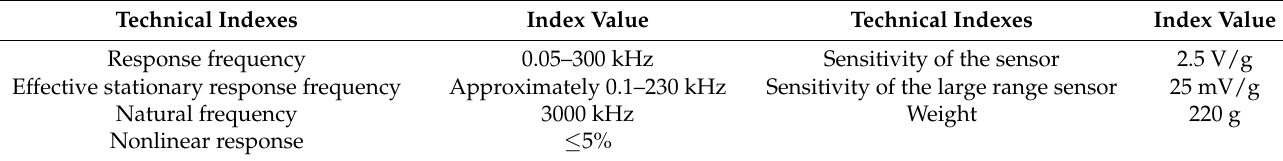
Table 6. Parameters of the sensor.